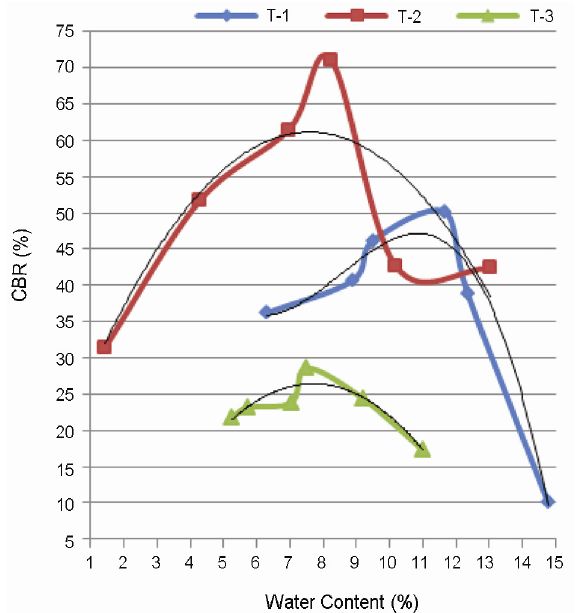
Fig. 6. Moisture-CBR